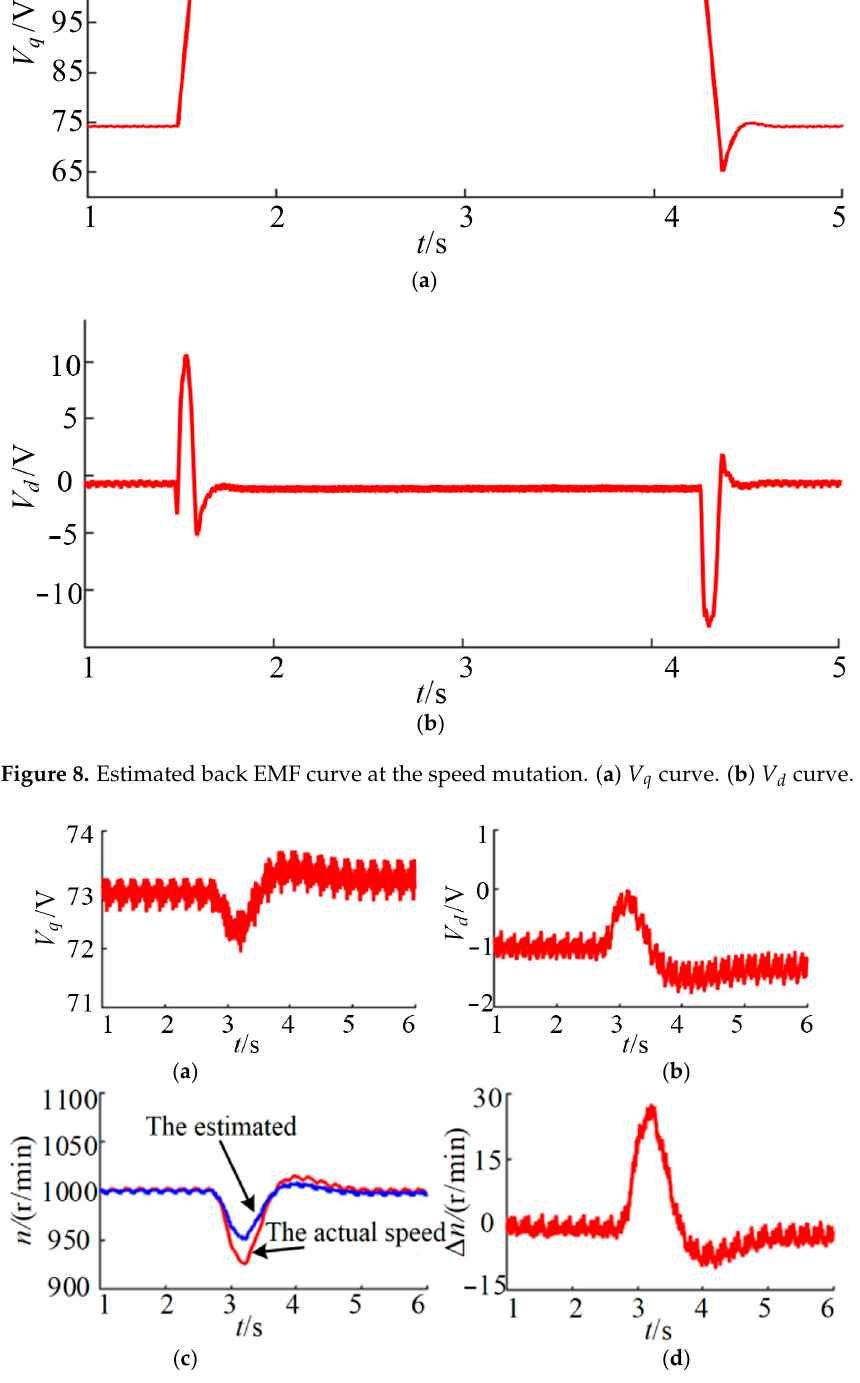
Figure 9. Experimental curves under the loading conditions. ( a ) V q curve. ( b ) V d curve. ( c ) Speed curve. ( d ) Speed estimation error curve.